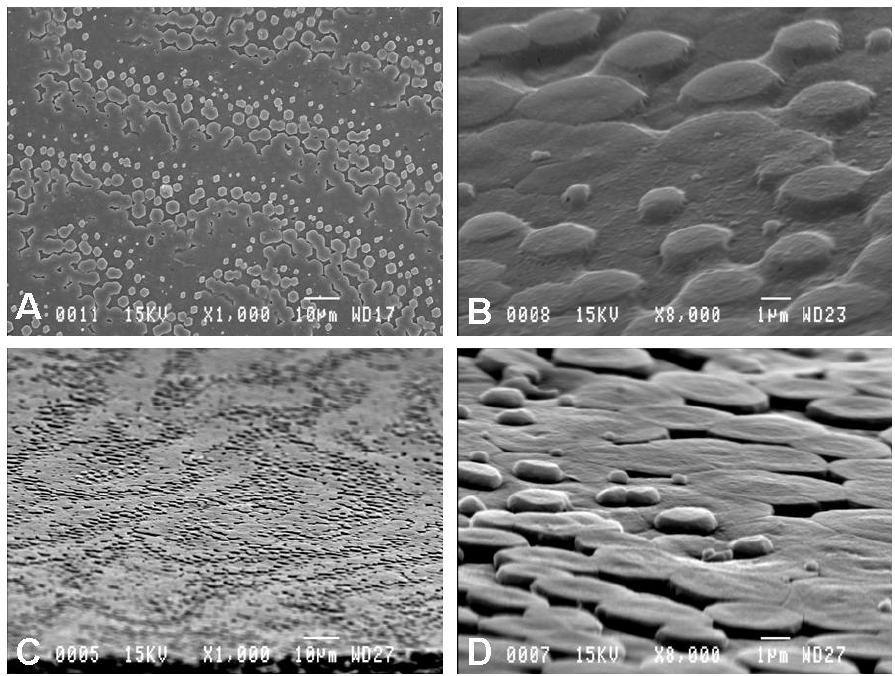
Figure 1. Scanning electron microscopy (SEM) images of nacre surface of pearl oyster kept